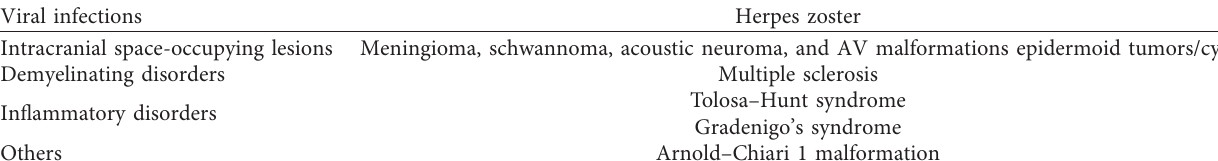
Table 1: Lesions and conditions that can present with trigeminal neuralgia-like pain with loss of corneal reflex.